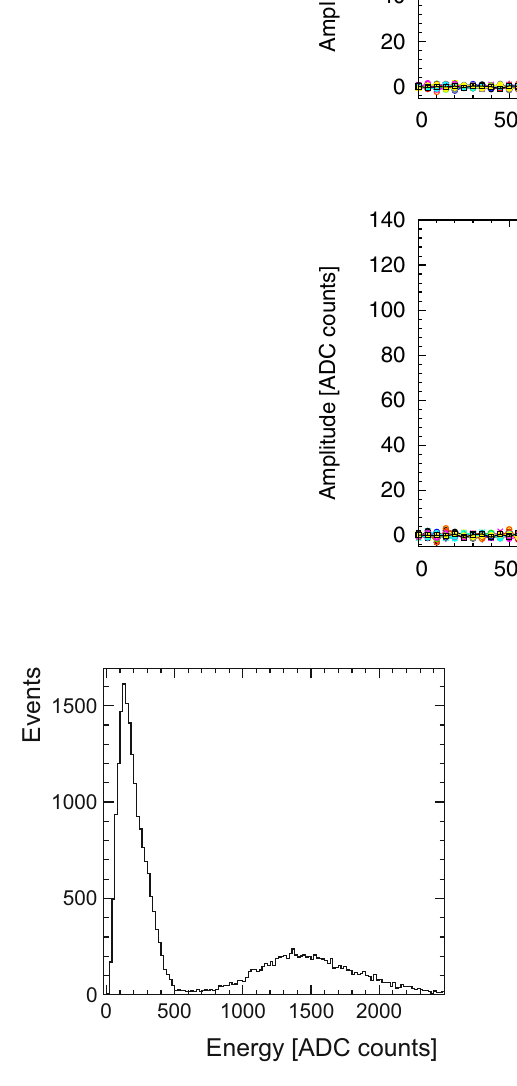
Fig. 13 The amplitudes as a function of time in the 32 channels of an example electron event after processing the signal in plane 1 (upper left), plane 2 (upper right), plane 3 (lower left) and plane 4 (lower right)